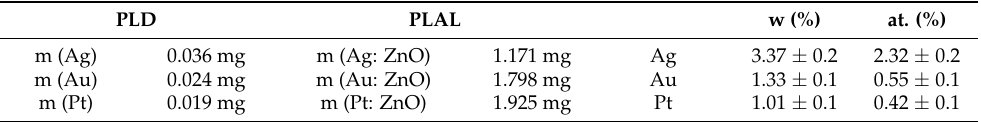
Table 1. Mass measurements of deposited metal layers involved in ablation and ablated doped ZnO nanoparticles (NP). Also, the mass (w) and atomic (at.) fractions of Ag, Au, and Pt in the produced nanoparticles were calculated. PLD PLAL w (%) at. (%) m (Ag) 0.036 mg